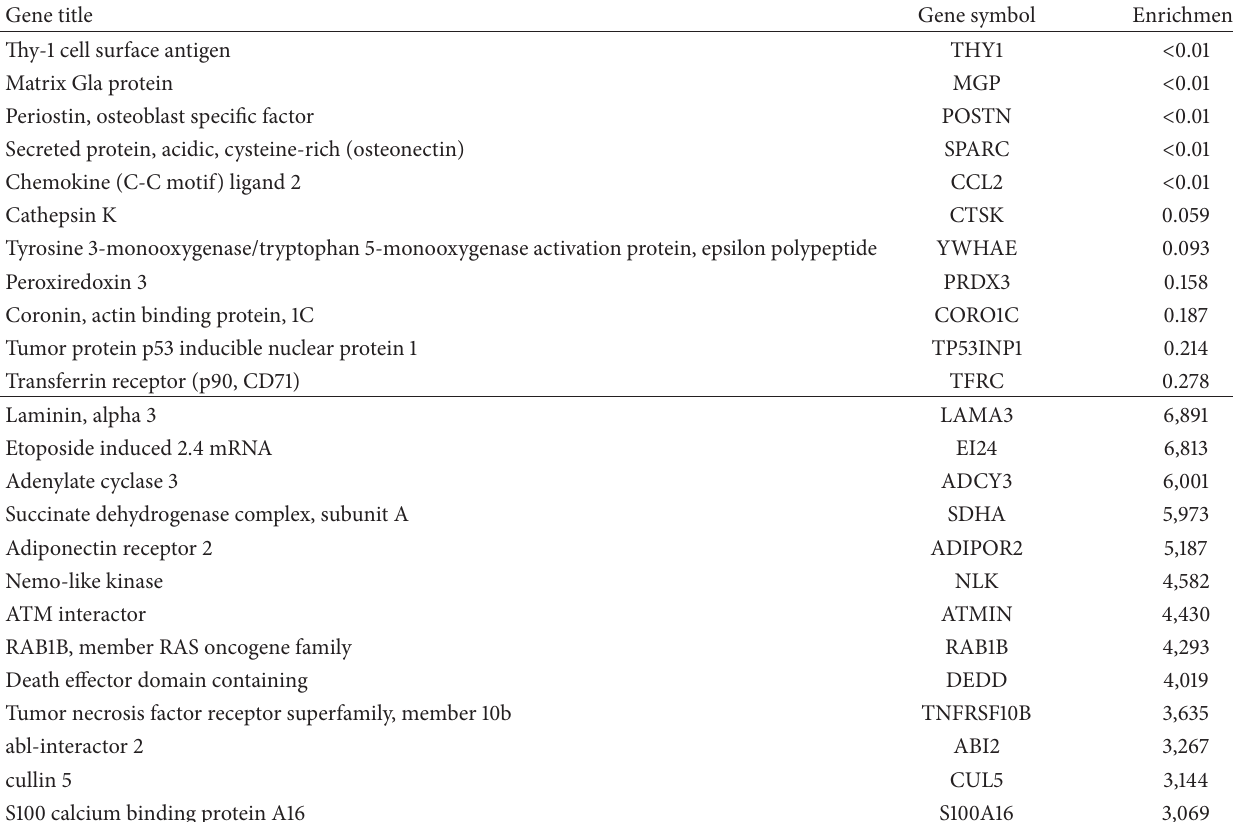
Table 1: Abundance of selected mRNAs in AGO complexes of DU145 PCa cells in comparison to prostate normal fibroblasts